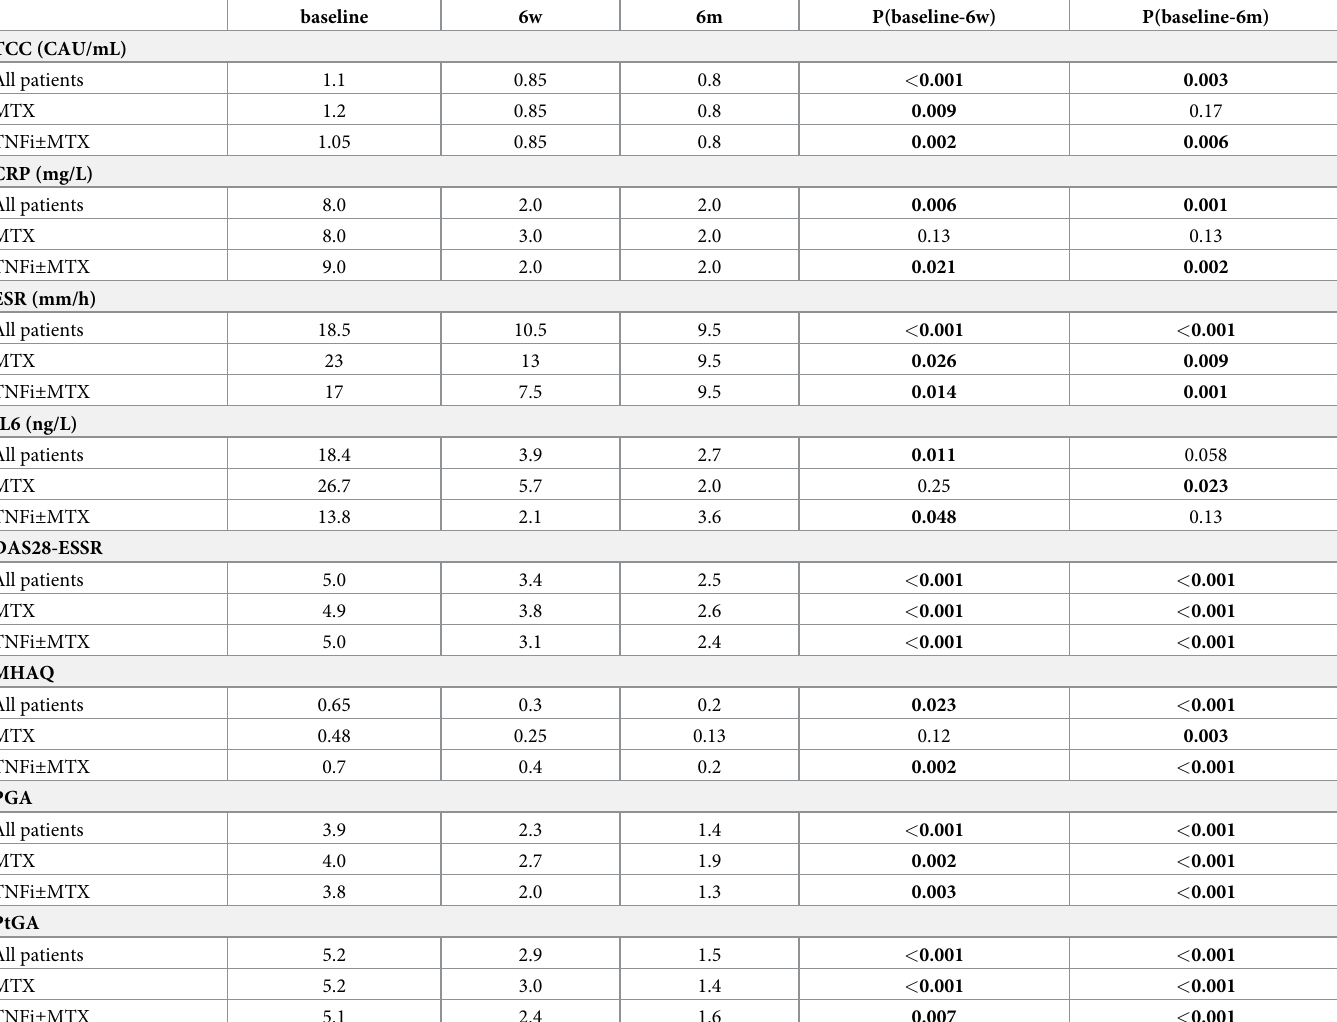
Table 4. Changes in TCC and some selected clinical and laboratory